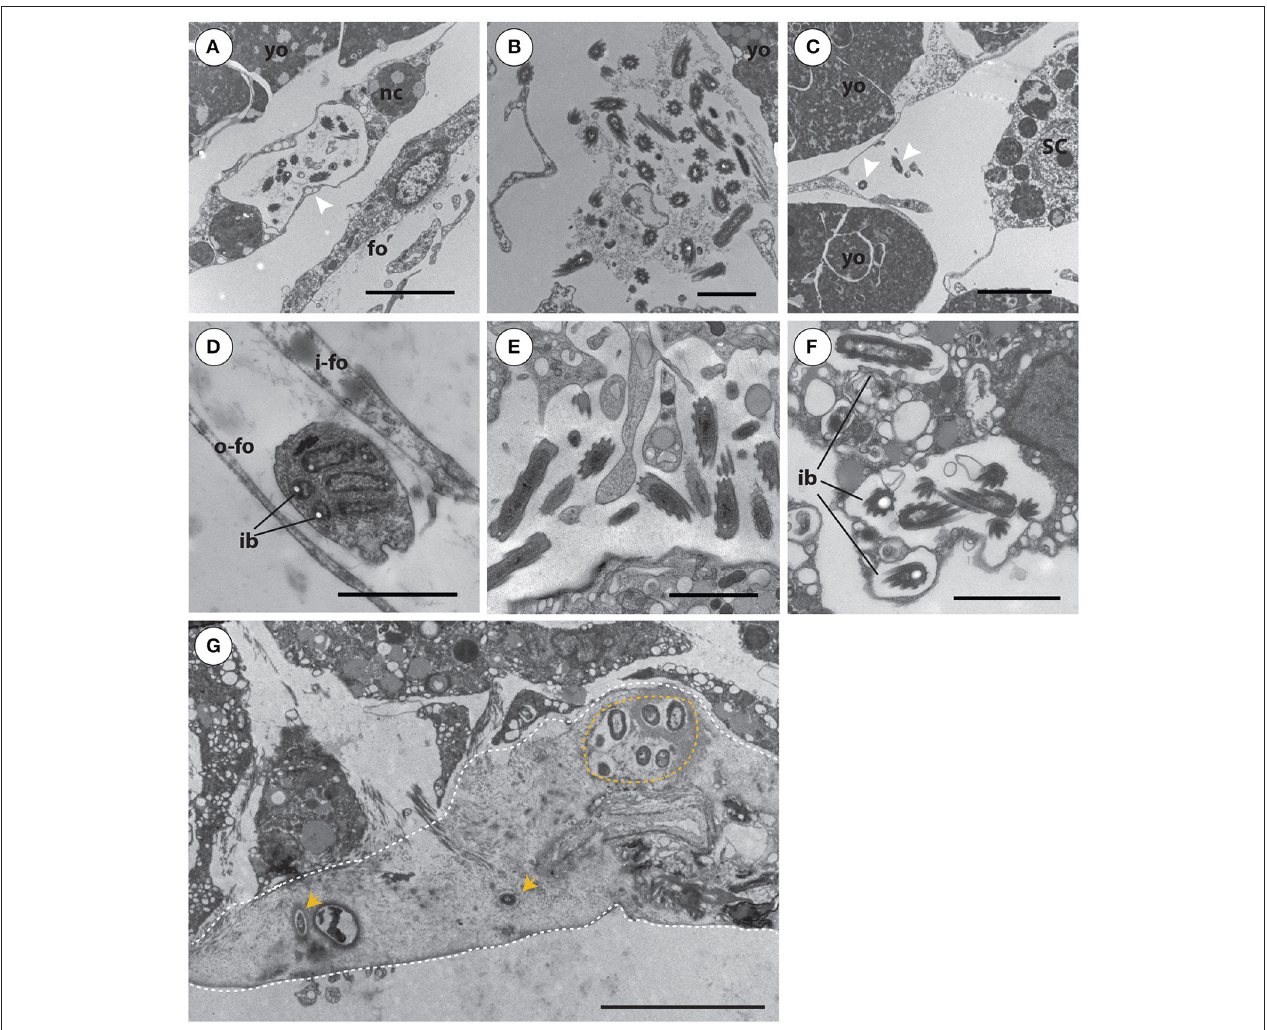
FIGURE 6 | Transmission electron microscopy images of Amphimedon queenslandica symbionts in multiple different life cycle stages that span cleavage-stage embryos to juveniles. (A) Bacterial symbionts in large pocket vesicles are transported into cleavage-stage (white) embryos by maternal nurse cells (arrowhead). Scale bar 5 µ m. (B) Upon entering cleavage-stage embryos, the nurse cells rupture and release their bacterial cargo into the extracellular space. Scale bar 2 µ m. (C) In blastula stage (brown) embryos, bacterial symbionts (arrow heads) are randomly distributed at low density through the extracellular space. Scale bar 2 µ m. (D) In blastula stage (brown) embryos, between the inner and outer embryonic follicle layer, sponge cells were observed phagocytosing symbiont bacteria. Scale bar 2 µ m. (E) By larval stages, individual symbionts are observed in highest density in the inner cell mass. Scale bar 2 µ m. (F) During metamorphosis of larvae into postlarvae (shown at 48h post-induction of metamorphosis), bacterial symbionts are predominantly observed toward the endosome, including often intracellularly, being phagocytosed by sponge cells. (G) In postlarvae by 48 hpi, a collagen- and spongin-rich layer has been excreted to adhere the postlarva to the settlement substrate. Through this extracellular spongin- and collagen-rich basal layer (outlined by dashed white line), foreign bacteria (orange arrowheads; orange circle) enter the sponge body from the environment. The most basal edge of the postlarva, where it has been detached from the substrate, is the lower dashed line of the image. Scale bar (A–F) , 2 µ m; (G) , 5 µ m. Yolk masses (yo), nurse cells (nc), inner follicle (i-fo) and outer follicle (o-fo) membrane, cilia (ci), and intracellular bacteria (ib) in sponge